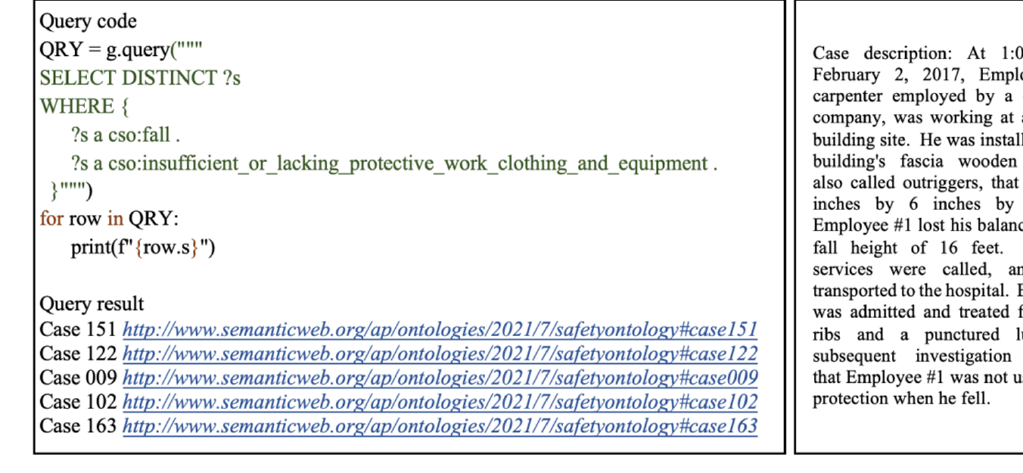
Figure 8. Query 1 code, result, and example of retrieved case.